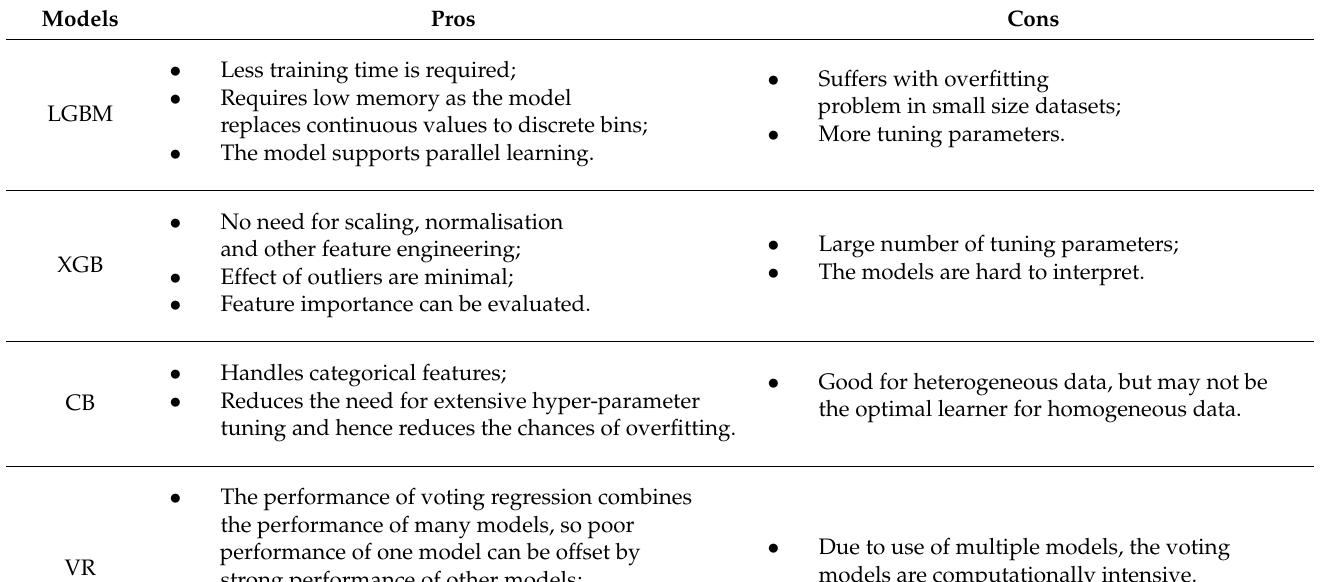
Table 2. Pros and cons of presented regression